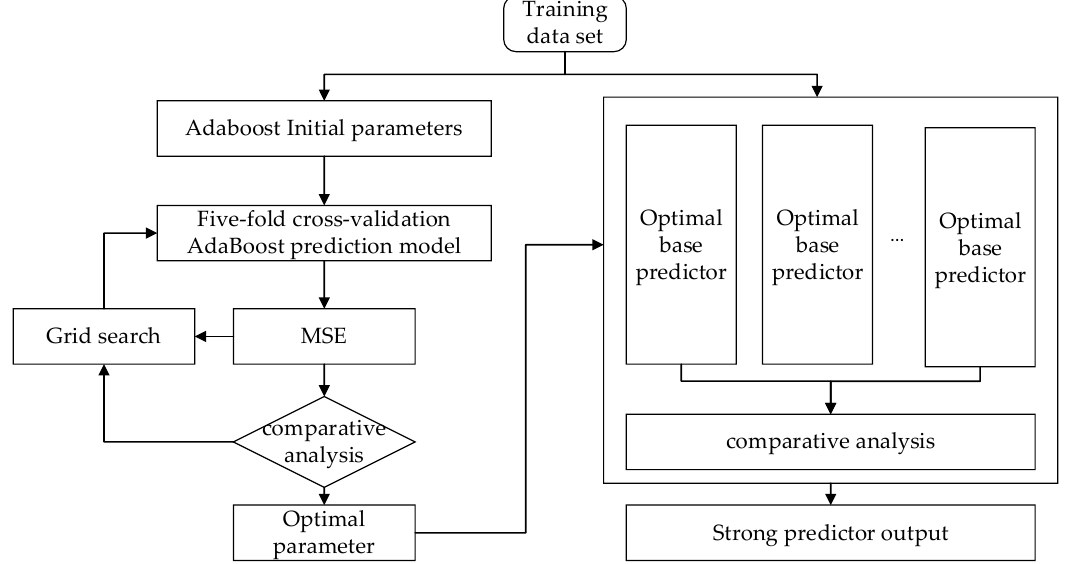
Figure 1. AdaBoost algorithm flowchart based on a grid search. MSE: Mean square error.